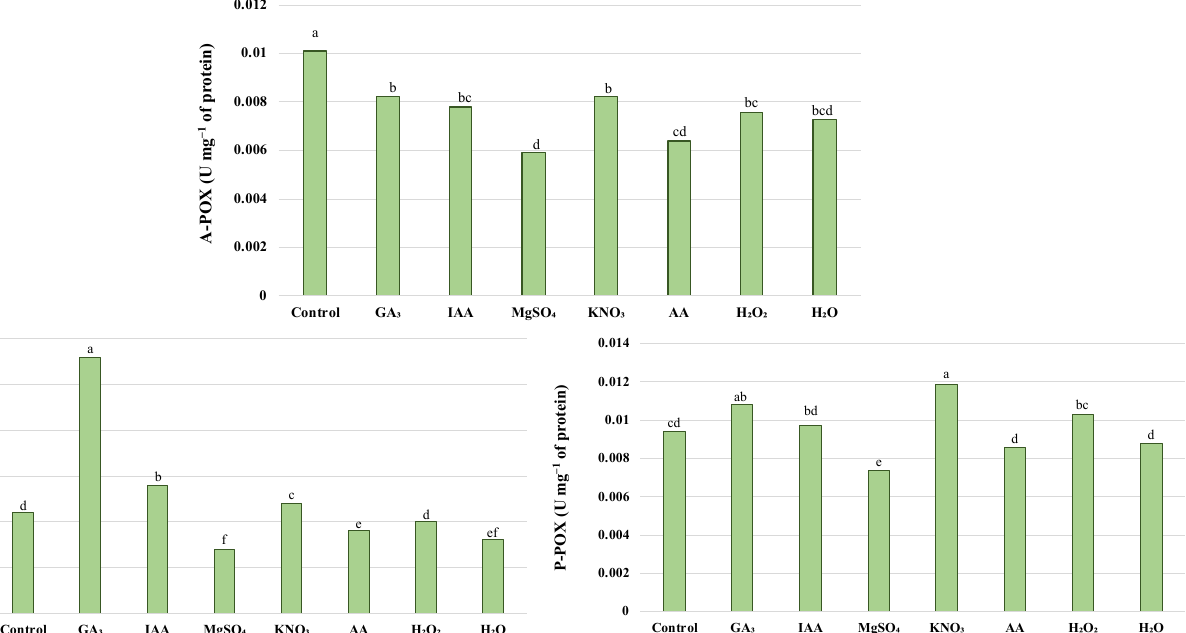
Figure 4. Activity of A-POX, G-POX, and P-POX in leaves of wheat seedlings after different priming treatments. Different letters above bars indicates that differences were not significant ( p > 0.05) using Tukey.